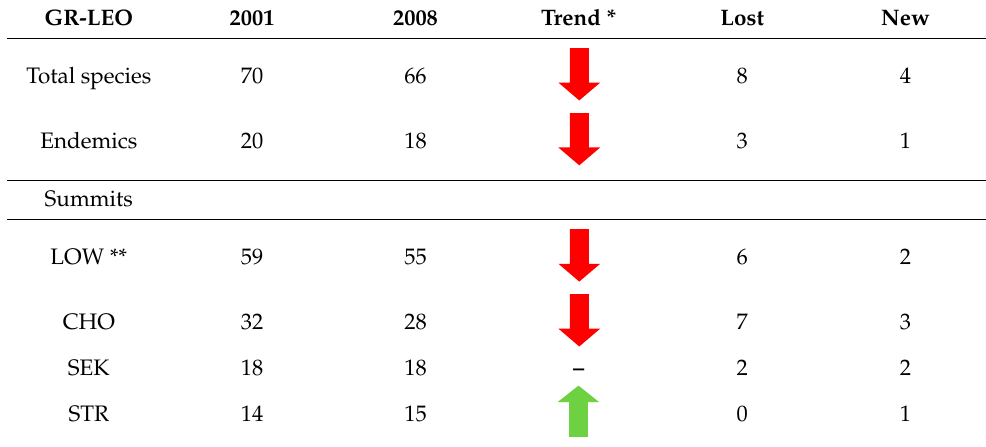
0 1 * red arrow indicates decreasing trend while green arrow increasing trend, ** LOW: low summit, CHO: Chorafas, SEK: South East Kakovoli, STR: Sternes. *red arrow indicates decreasing trend while green arrow increasing trend, Mean species richness at the 5 + 10 m SAS was highest at the lower summit (LOW) and ** LOW: low summit, CHO: Chorafas, SEK: South East Kakovoli, STR: Sternes. lowest at the highest summit (demonstrate a trend in decreasing richness with